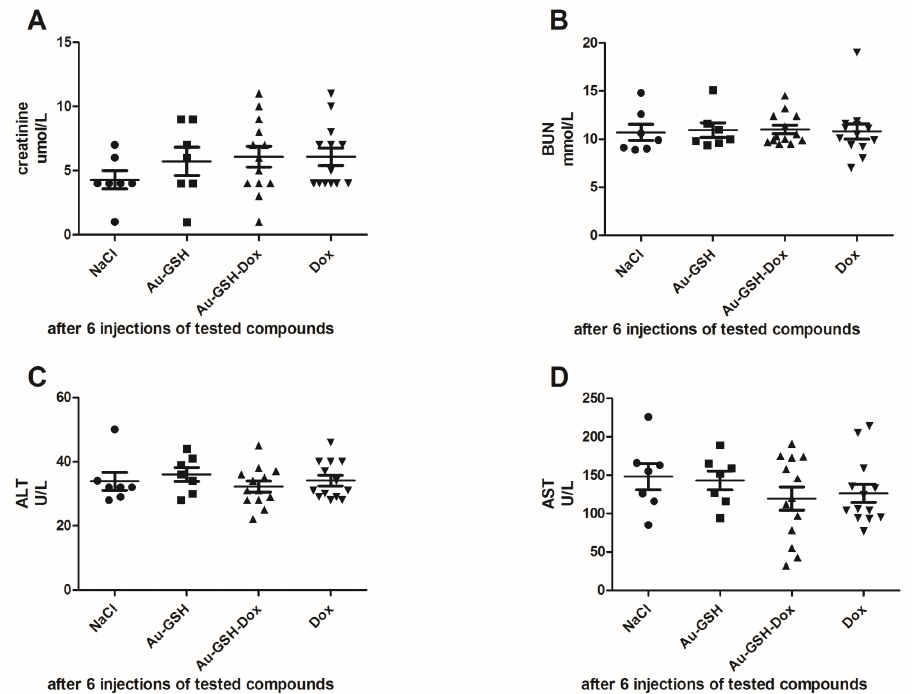
Figure 8. Statistical analyses of the levels of creatinine ( A ); BUN ( B ); ALT ( C ) and AST ( D ) in mice between treatment groups.